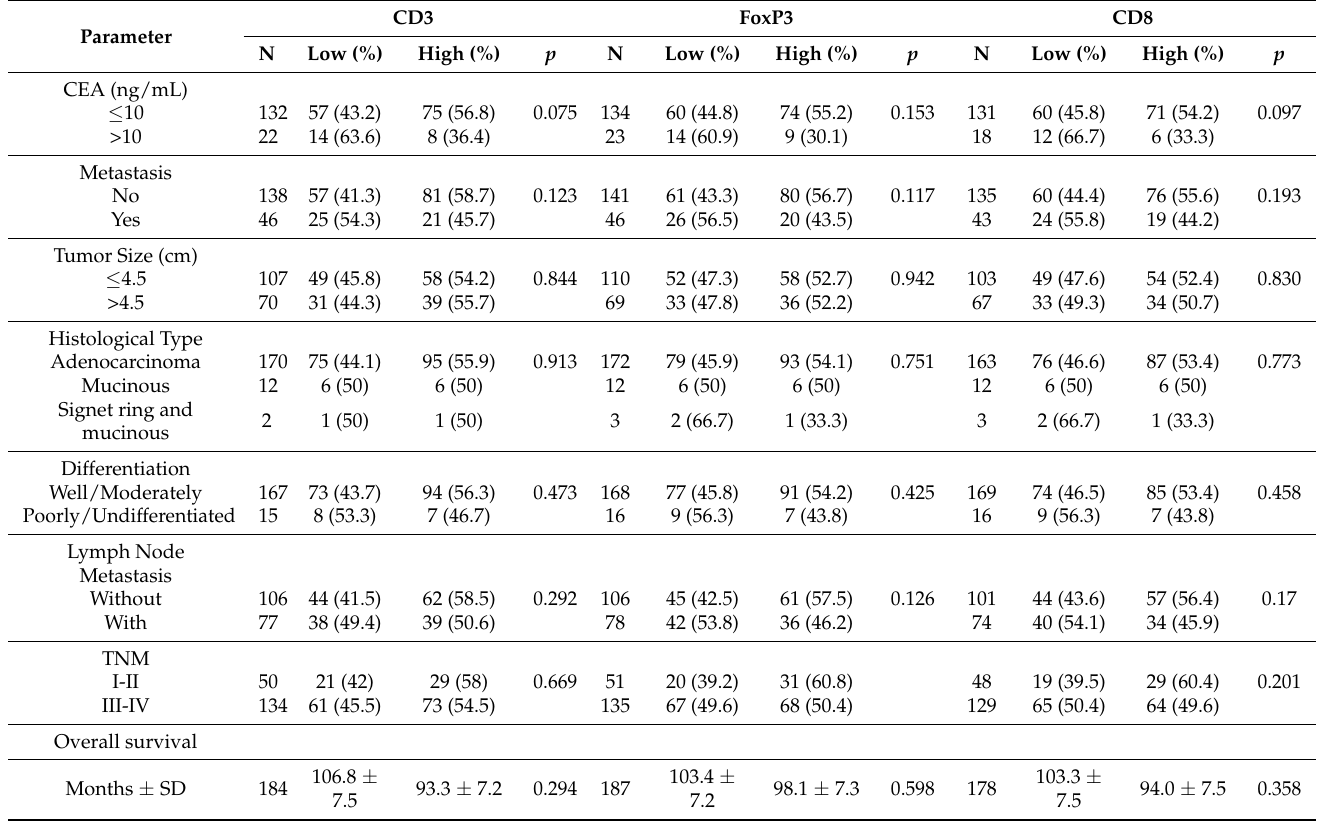
Table 5. Association of intratumor infiltration of CD3 + , FoxP3 + , and CD8 + T lymphocytes with pathological